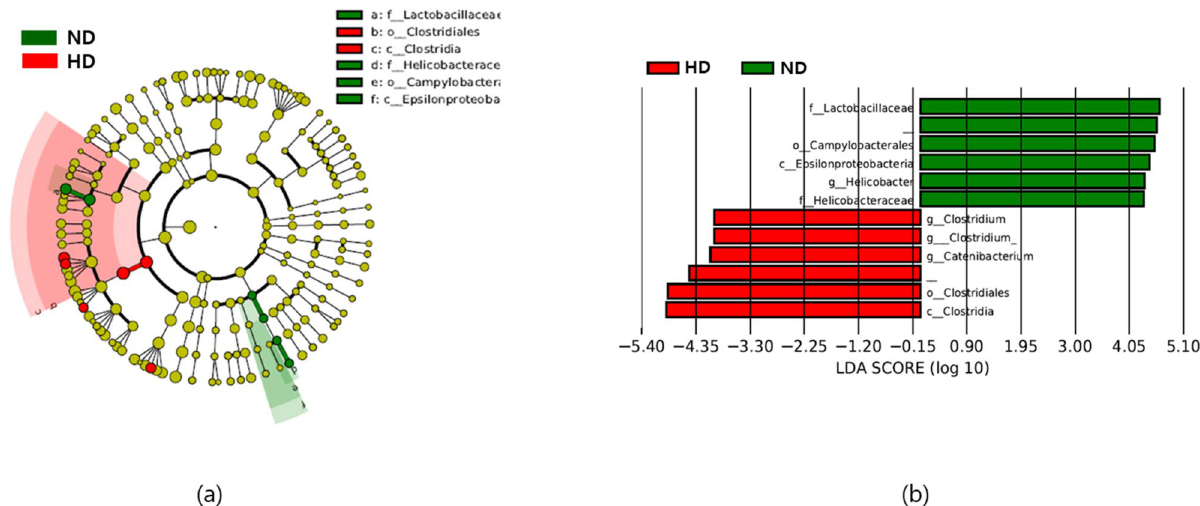
Figure 7. Differential abundance of taxa in ND and HD groups. ( a ) Cladogram. ( b ) Bar plot depicting bacterial taxa according to LDA. ND normal diet group, HD high energy intake